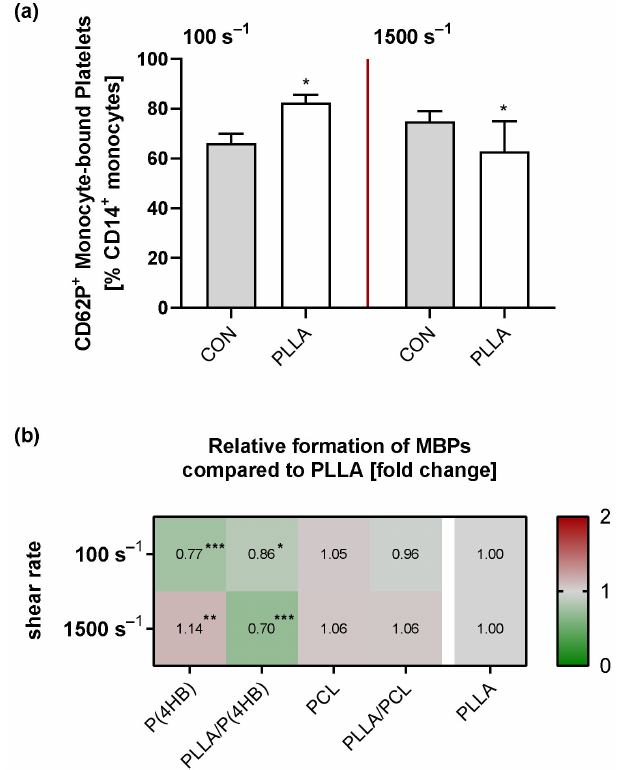
Figure 6. CD62P+ Monocyte-bound platelets (MBPs) on polymer surfaces. Human platelets and leukocytes were isolated separately and resuspended in platelet poor plasma (PPP) at a physiological concentration of 3 × 10 8 platelets/mL and 5 × 10 6 leukocytes/mL. Blood cell suspensions were circulated through a parallel plate flow chamber system, containing the different polymers, with shear rates of 100 s − 1 and 1500 s − 1 . After flow exposure, CD62P+ MBPs were identified within the monocyte population by CD14/CD62P expression. ( a ) Bars show mean proportion of CD14+/CD62P+ MBPs ± SD. ( b ) To visualize the effect of the different polymers, the heat map shows the relative mean proportion of CD14+/CD62P+ MBPs compared to PLLA. All experiments were repeated 5 times. Significances with regard to the corresponding control are indicated with * p < 0.05, ** p < 0.01 and *** p <